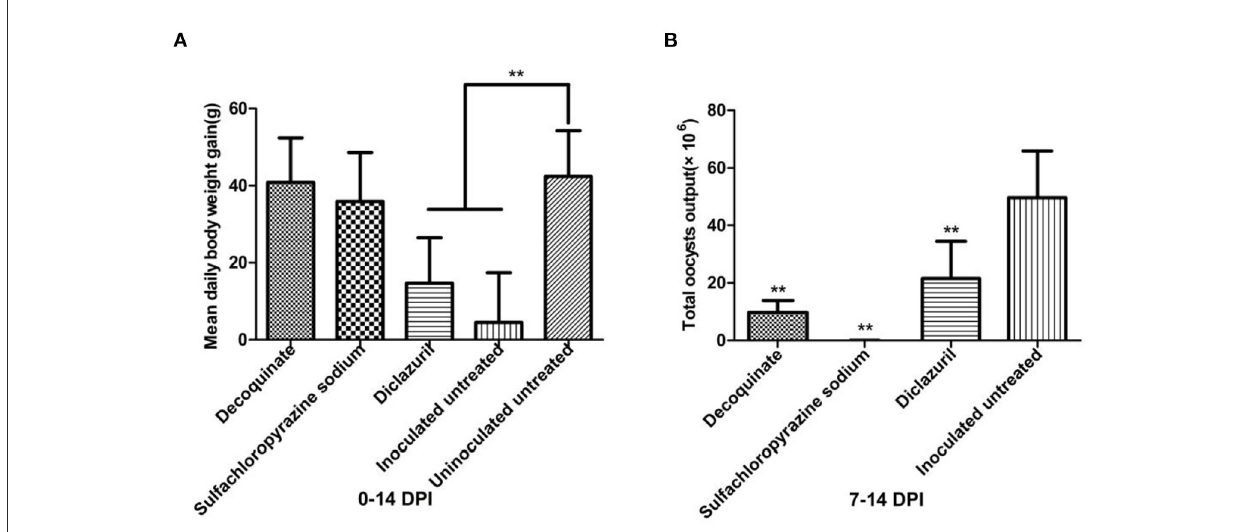
FIGURE5 Comparison of mean daily body weight gain and total oocysts output in different groups. in drug sensitivity experiment of E. kongi. (A) Average daily weight gain. (B) Total oocyst output. DPI, day post inoculation. ** P < 0.01 (Student’s t